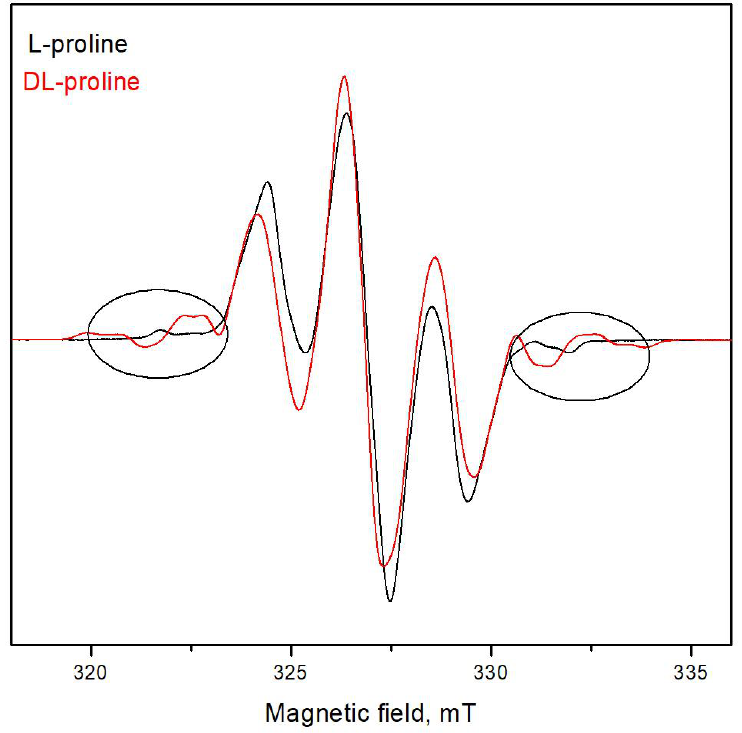
Figure 2. EPR spectra of L- and DL-proline irradiated with 25 kGy. Figure 2 . EPR spectra of L- and DL-proline irradiated with 25 kGy. Figure 2 . EPR spectra of L- and DL-proline irradiated with 25 kGy.